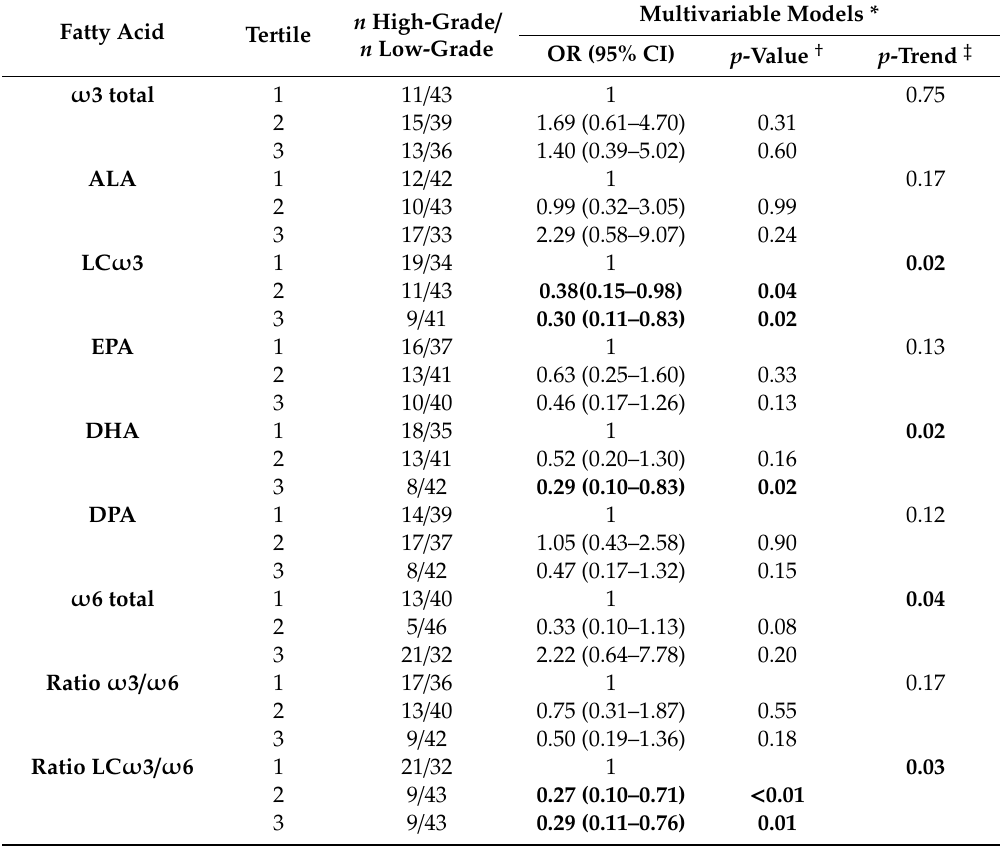
Table 7. Associations between fatty acid intake assessed by the web-FFQ and high-grade prostate cancer. Fatty Acid